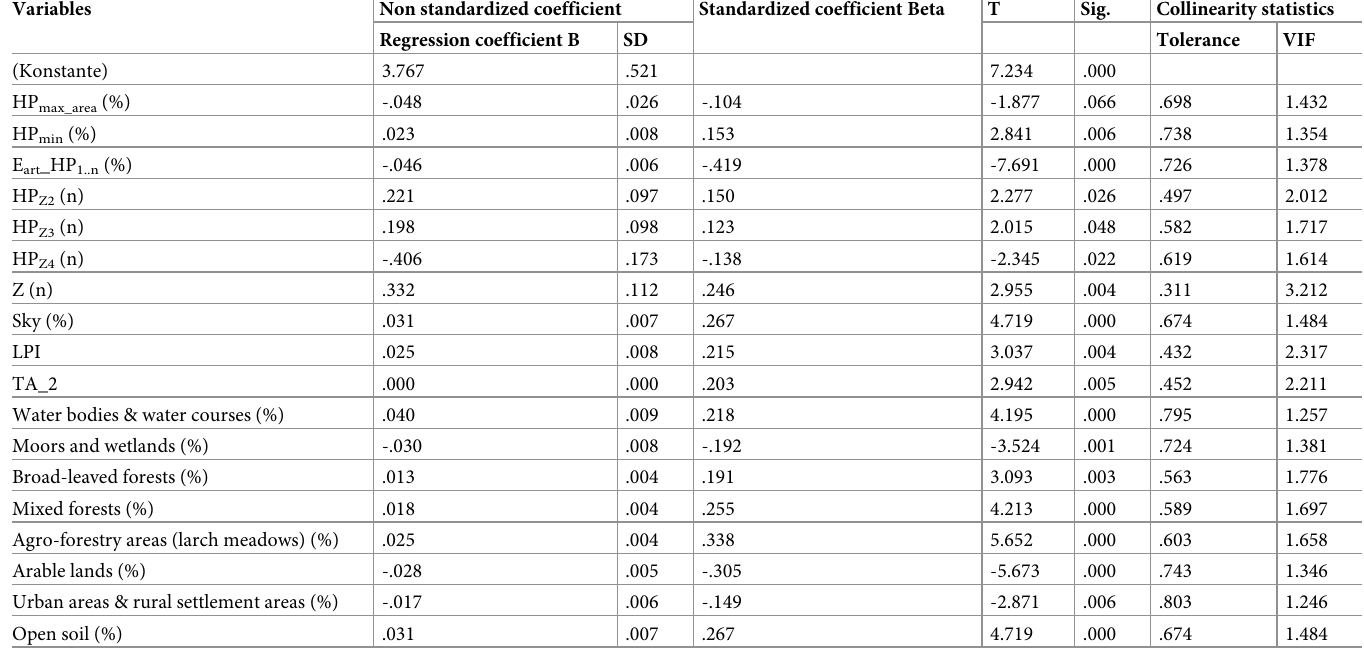
Table 4. Result of the backward stepwise linear regression, including landscape metrics, photo content indictors and hotspot predictors with tolerance > 0.1 and variance inflation factor (VIF) < 10 during collinearity diagnostics. Only variables with p < 0.1 are